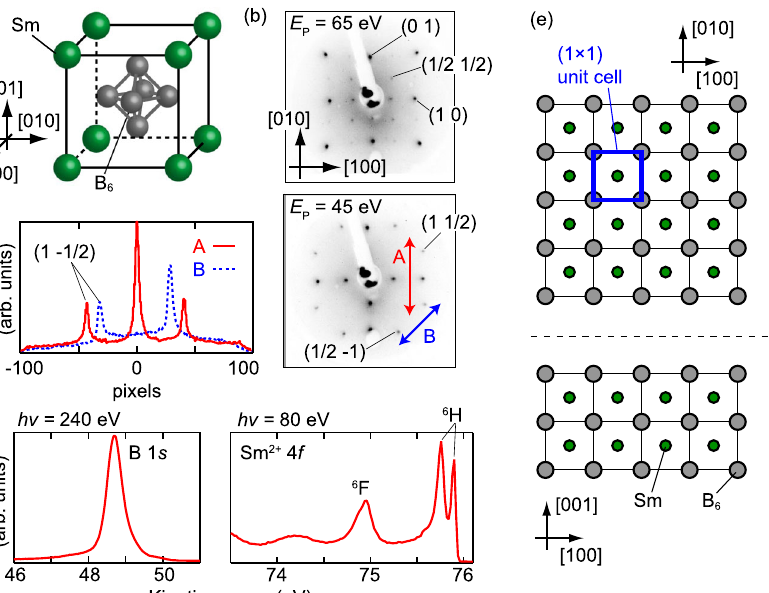
Fig. 1| SurfacepreparationofthevicinalSmB 6 (001)surface.a Crystal structure of SmB 6 . b LEED patterns of the cleaned SmB 6 (001) surface taken at 100K. The distortions in the patterns are due to the fl at microchannel plate in the LEED electron optics. Two-headed arrows indicate the lines along which the pro fi les in ( c ) were taken. c LEED line pro fi les taken from the pattern shown in ( b ). d Angle-